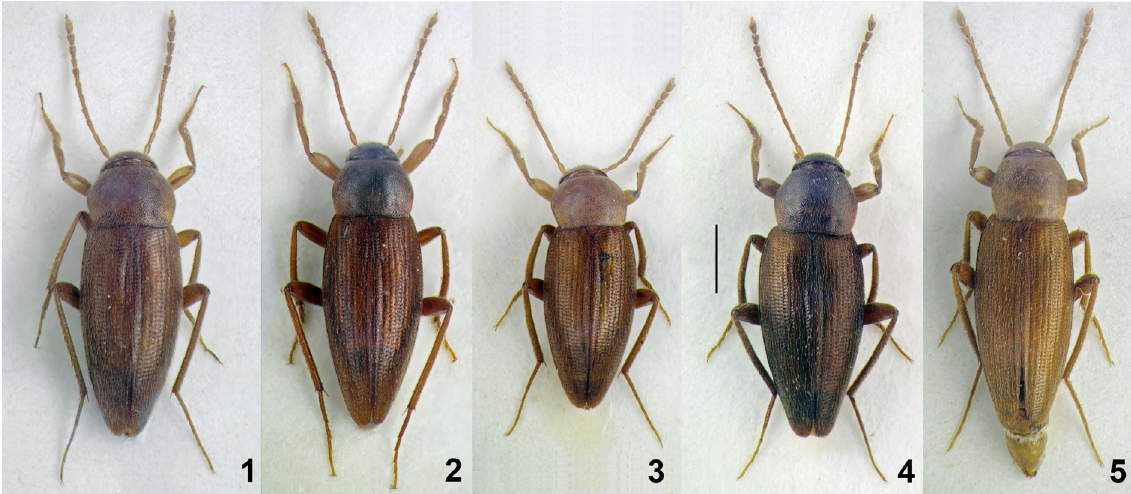
Figs 1–5. Speonemadus of the escalera i -group habitus. 1 . S. algarvensis sp. nov. (Gruta do Vale Telheiro, Portugal). 2 . S. angusticollis (Kraatz, 1870) (Rute, Spain). 3. S. bolivari (Jeannel, 1922) (Ardales, Spain). 4 . S. breuili (Jeannel, 1922) (Motillas, Spain). 5 . S. escalerai (Uhagón, 1898) (Jumilla, Spain). Scale bar = 1